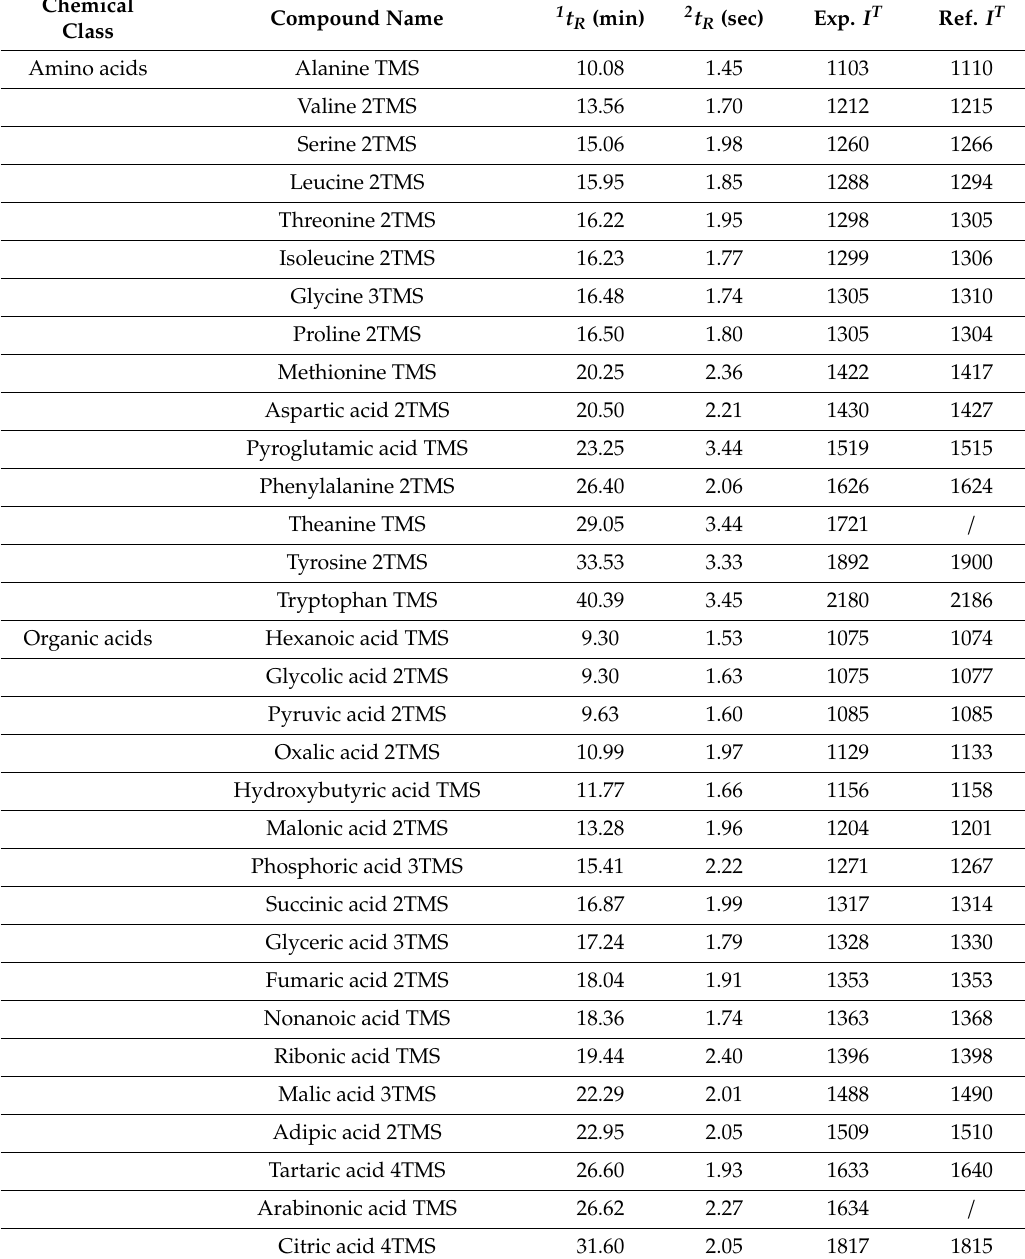
Table 1. List of 74 targeted analytes together with retention times in first and second dimensions ( 1 t R , 2 t T (experimental and reference NIST Chemistry WebBook, SRD 69 [https: // webbook.nist.gov / R ), and I chemistry / gc-ri / ]